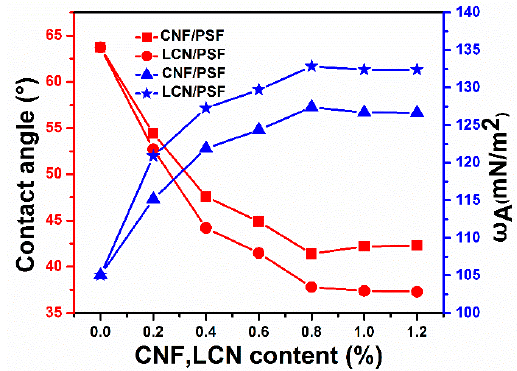
Figure 11. Effect of CNF and LCN contents on contact angle and surface energy of membranes.